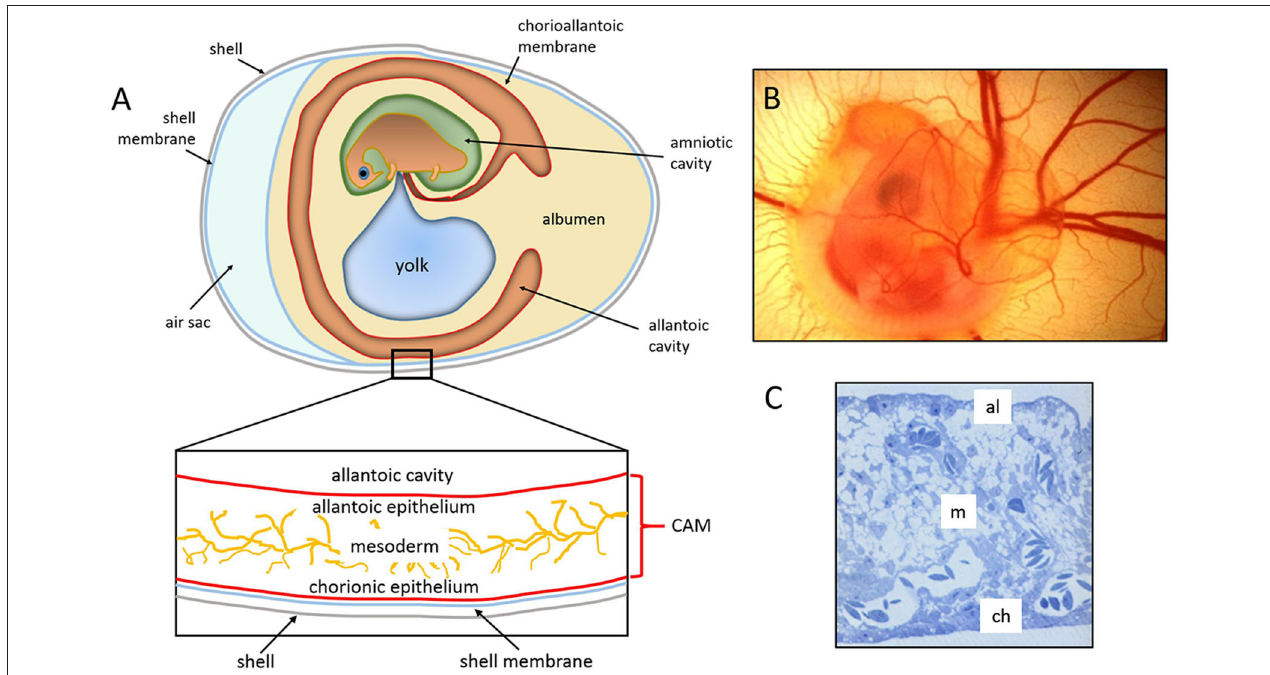
FIGURE 1 | The chick embryo and its chorioallantoic membrane. (A) Schematic drawing of the general structure of a 5 day old chick embryo in the egg and the three-tissue layers of the chick chorioallantoic membrane (CAM). (B) Semithin section of the CAM of a 12 day old chick embryo showing the chorionic epithelium (ch), the vascularized mesoderm (m), and the allantoic epithelium (al). (C) 5 day old chick embryo photographed in ovo [ (B,C) , reproduced from ( 75)].